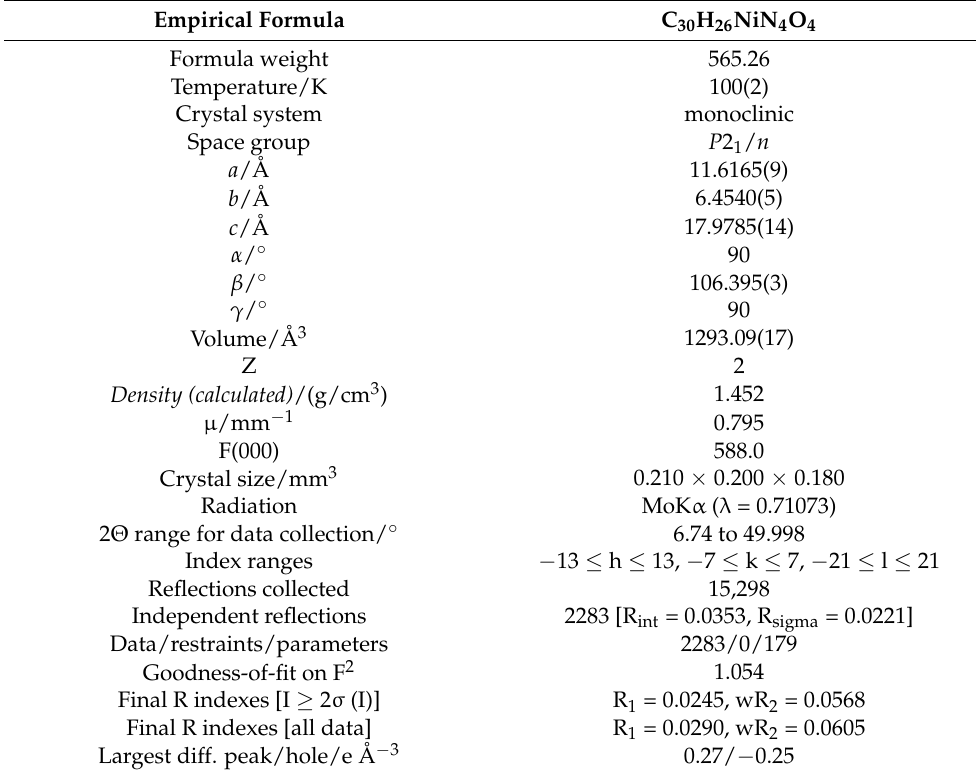
Table 1. Crystal structure and refinement details for